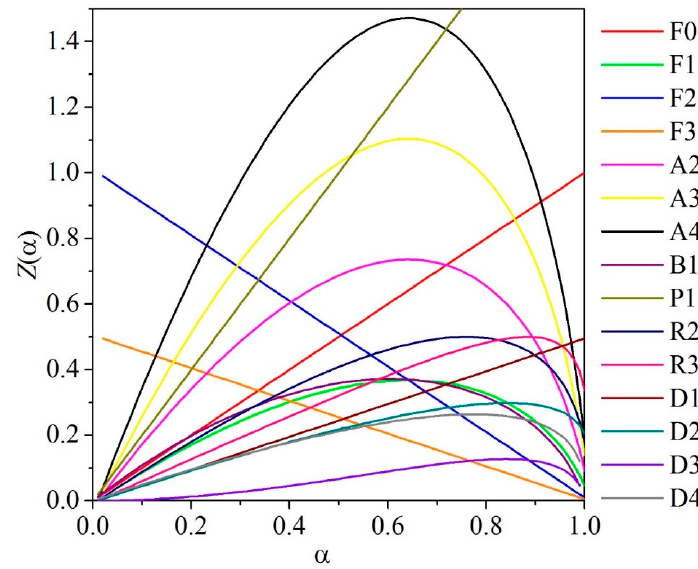
Figure 9. Z( α ) theoretical master plot for reaction mechanisms in Table 1.